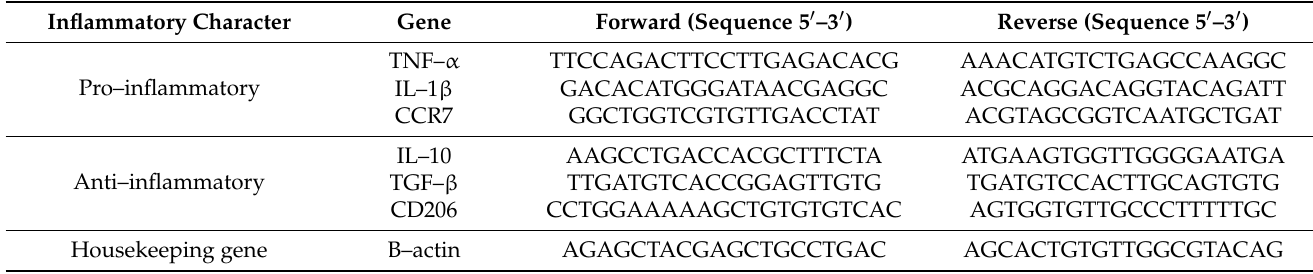
Table 1. Sequences of primers used for quantitative real time polymerase chain